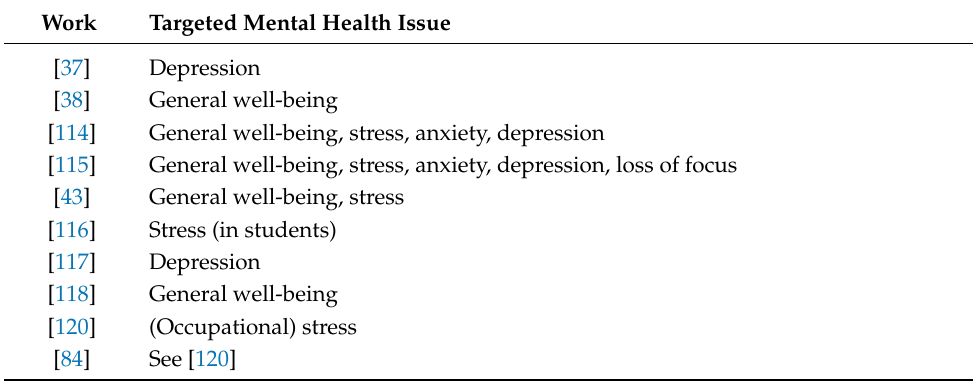
Table 1. Answering RQ1. Which mental health issues do the systems